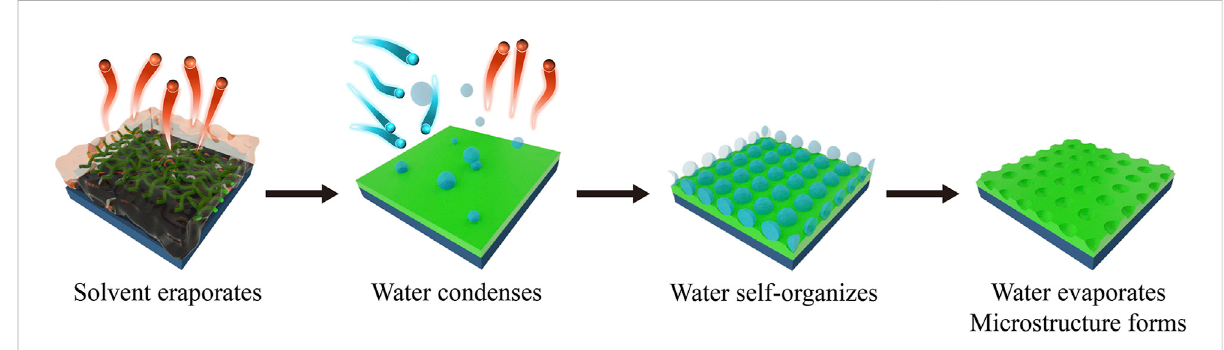
FIGURE 2 Fabrication of honeycomb patterns using breath fi gure